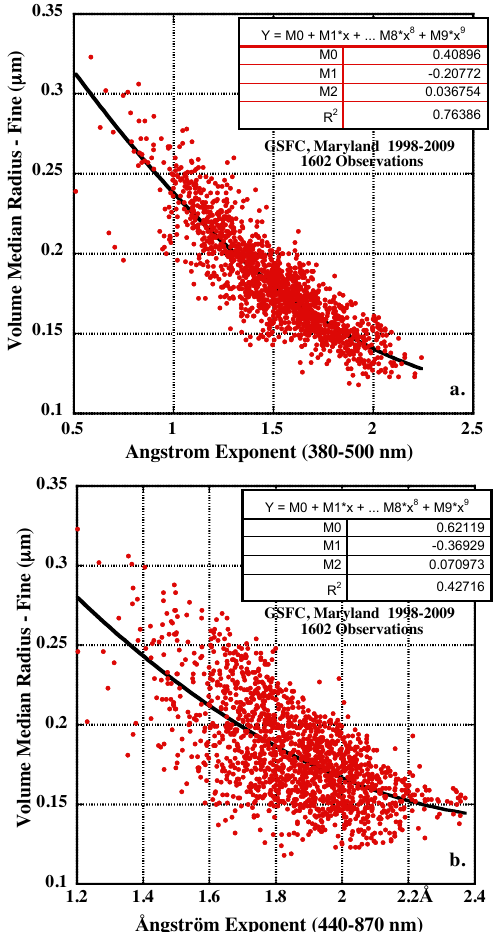
Figure 4. Relationship between the fine mode radius retrieved from the Dubovik and King (2000) algorithm and the Ångström expo- nent (for two different wavelength intervals) for the GSFC site. The Level 2.0 (cloud screened and quality assured) climatological data from 1998 to 2009 are shown for AOD (440nm)>0.2 and fine mode